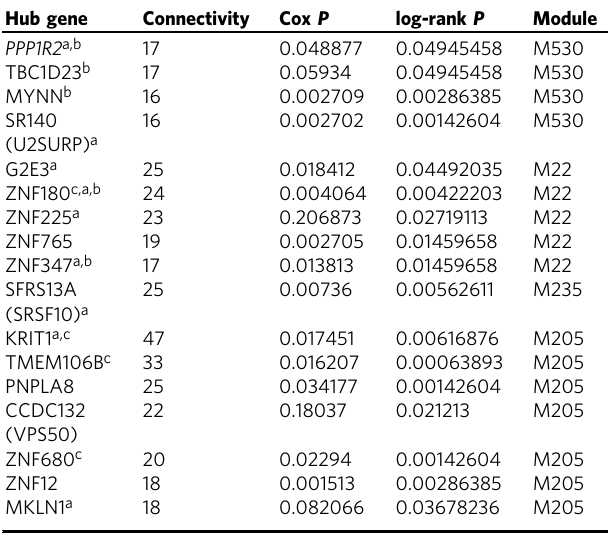
Table 1 List of top nominated key genes associated with prognosis in primary melanoma